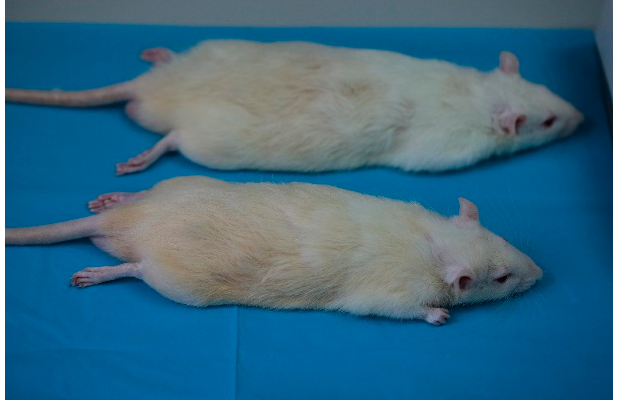
Figure 1. White laboratory rats of the Wistar line.